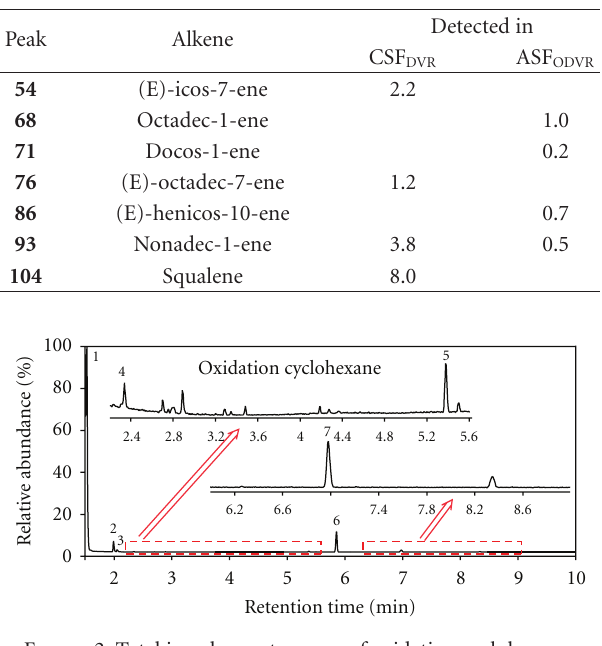
Figure 2: Total ion chromatograms of oxidation